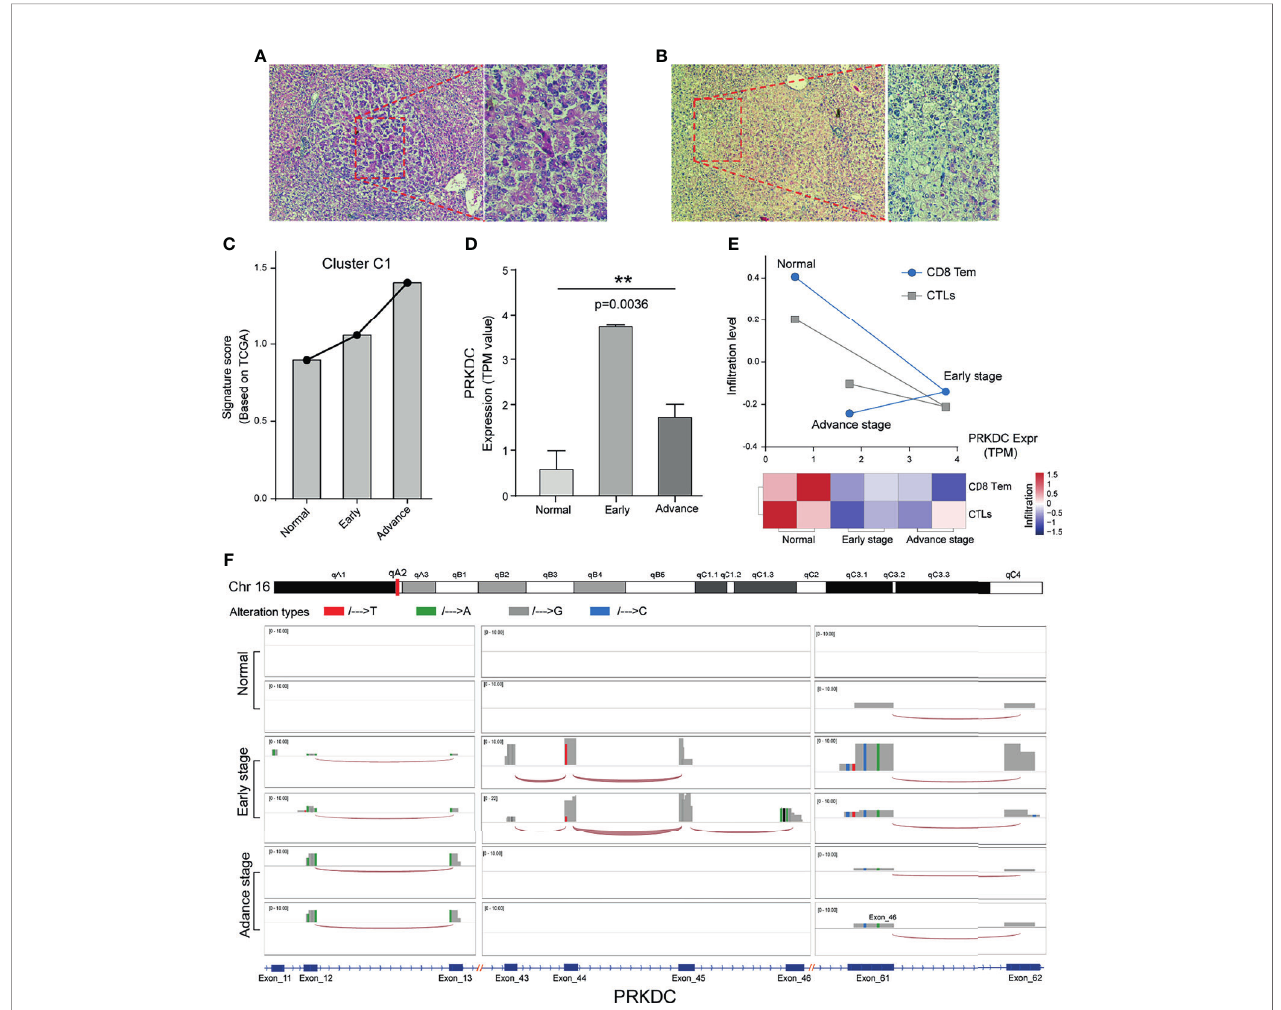
FIGURE 6 | Cluster C1 signature and PRKDC characteristics of HCC in vivo . (A, B) Liver tissue of aHCC rats; H&E staining demonstrates clear lesions in hepatic nodules, composed of pleomorphic cells with prominent glandular and trabecular formation, as well as eosinophilic focus of cellular alteration with pale pink cytoplasm. (C) Relative Cluster C1 signature quanti fi cation in DEN-induced eHCC rat model, compared with aHCC and normal. TPM value was applied for gene expression comparison. (D) Relative mRNA quanti fi cation of PRKDC in DEN-induced eHCC rat model. TPM, transcripts per million reads. ** indicates p = 0.0032. (E) Evaluation of CD8 Tem and CTL in fi ltration level and relationship to PRKDC in eHCC rat model. Red represents immune status, and blue represents in fi ltration grades. (F) Landscape of PRKDC genomic map in three groups of HCC rat models. Three high-frequency nucleotide variation regions of PRKDC were selected to be displayed in the windows. Different alteration tendencies of A/T/G/C were colored with red, green, gray, and blue. The height of the bar represents the read count number. The splice junction track between the different exon was connected by an arc. HCC, hepatocellular carcinoma; aHCC, advanced-stage hepatocellular carcinoma; DEN, diethylnitrosamine; eHCC, early-stage hepatocellular carcinoma; CTL, cytotoxic T